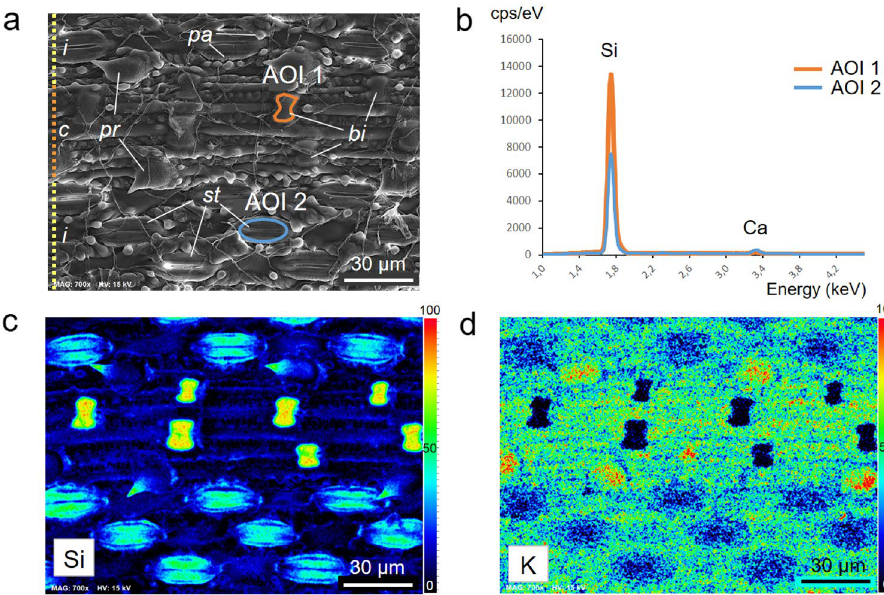
Fig. 8 Structure of the abaxial leaf-blade of Guadua bamboo (Primavera-20). a SEM image with two defined AOIs; b EDS spectra in the AOIs with the most prominent peaks labeled for the minerals they represent; c-d EDS maps Si and K, respec- tively. Abbreviations: c = costal zone (indicated by orange dot line in the left), i = intercostal zone (indicated by yellow), st = stomata, pr = prickle, pa = papillae, st = stoma, bi = bilobate short